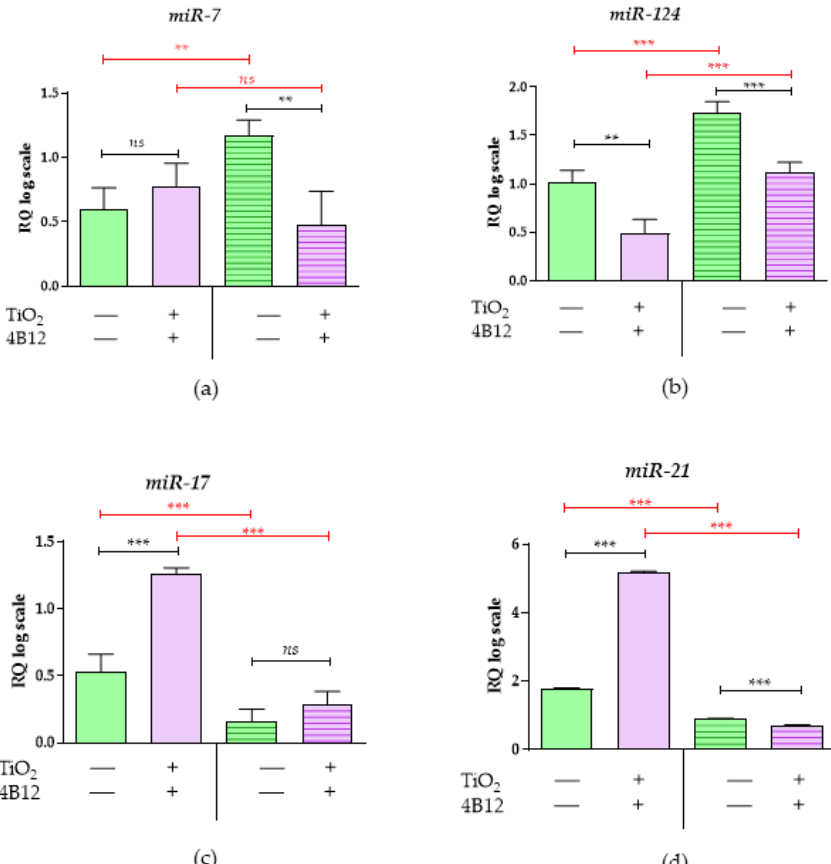
Figure 11. The expression of miRNA associated with osteogenic potential. The analysis of the control cultures (TiO 2 ALD coatings -) and the cultures propagated on TiO 2 coatings obtained by ALD (TiO 2 ALD coatings + ; experimental culture) examined ( a ) miR-7, ( b ) miR-124, ( c ) miR-17, and ( d ) miR-21. The transcripts’ profiles were measured using the RT-qPCR technique. The relative quantification (RQ) was performed using the RQ MAX method, and the results are presented in a log scale. (significant differences are marked with asterisks (*** p < 0.001; ** p < 0.01), non-significant results are marked as ns).